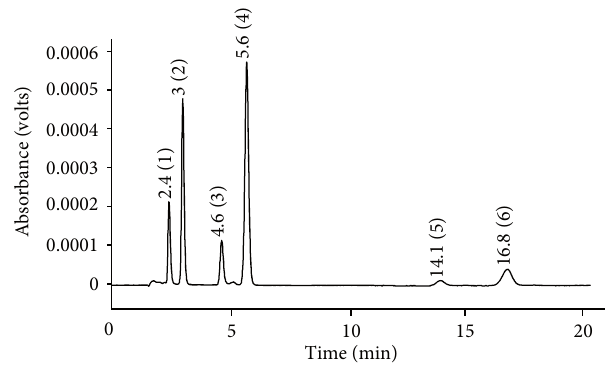
(Figure 3). Calibration curves (9-point for determining analytical parameters and 7-point for routine analysis) were linear over the whole tested range (Figure 4). e calibration curve parameters obtained as an average from ten standard curves are shown in Table 2. e lowest concentration